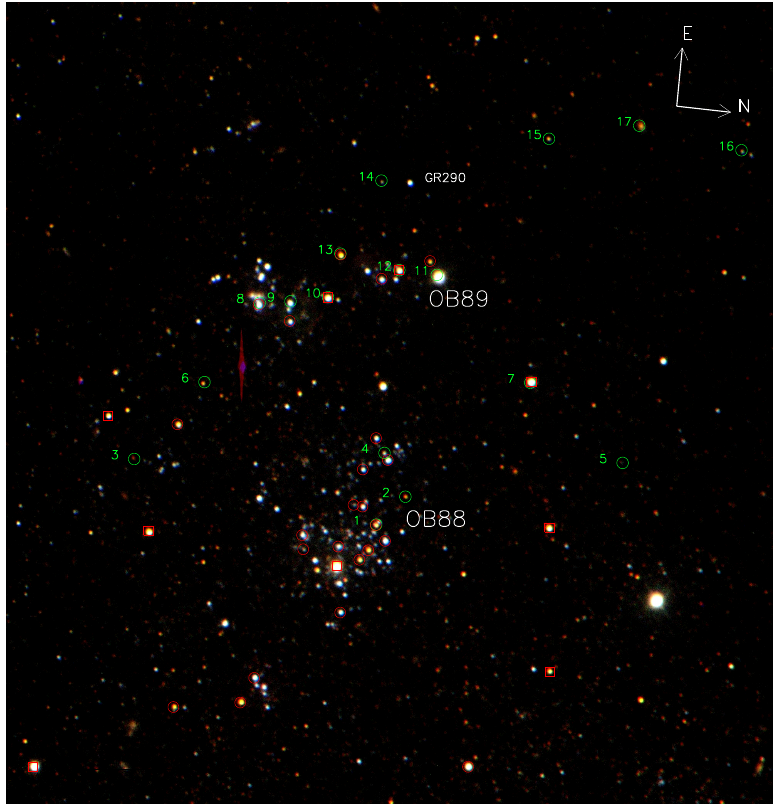
Figure 1. Identification chart of GR290 vicinity and OB88 and OB89 associations. The colour picture is a combination of three direct images, with blue corresponding to B filter, green—to V and red—to R filter, all obtained with 2.5 m telescope of the Caucasian Mountain Observatory (CMO) of the Sternberg Astronomical Institute of Moscow State University. Green circles mark the stars studied in this work and red ones studied by Massey et al. [15,16]. Red squares are stars considered to be foreground objects by Massey et al.